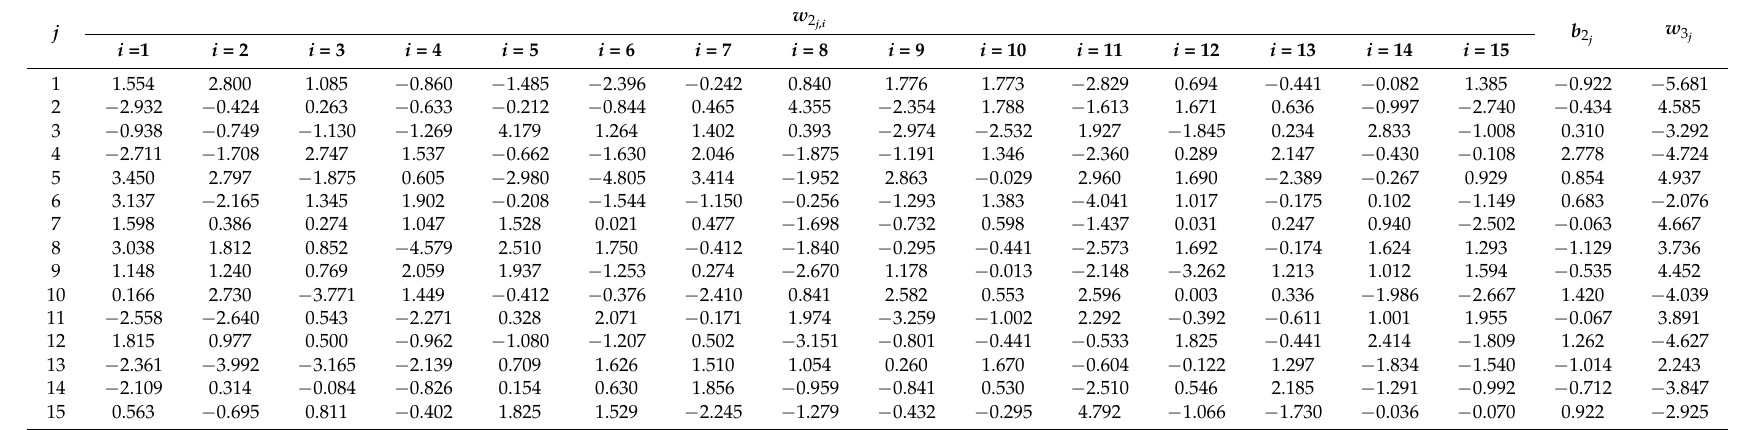
Table 5. Weight and biases of each neuron in the second hidden layer of the ANN structure of the bubble point pressure